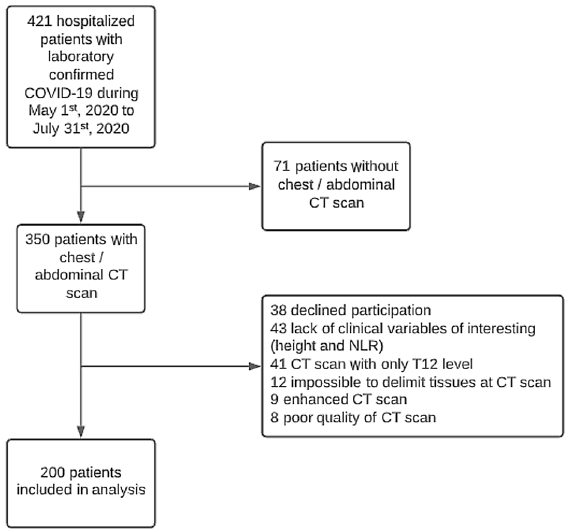
Figure 1. Flow-chart showing the patient recruitment process. Abbreviations: NLR: Neutrophil-to-lymphocyte ratio; CT: Computed